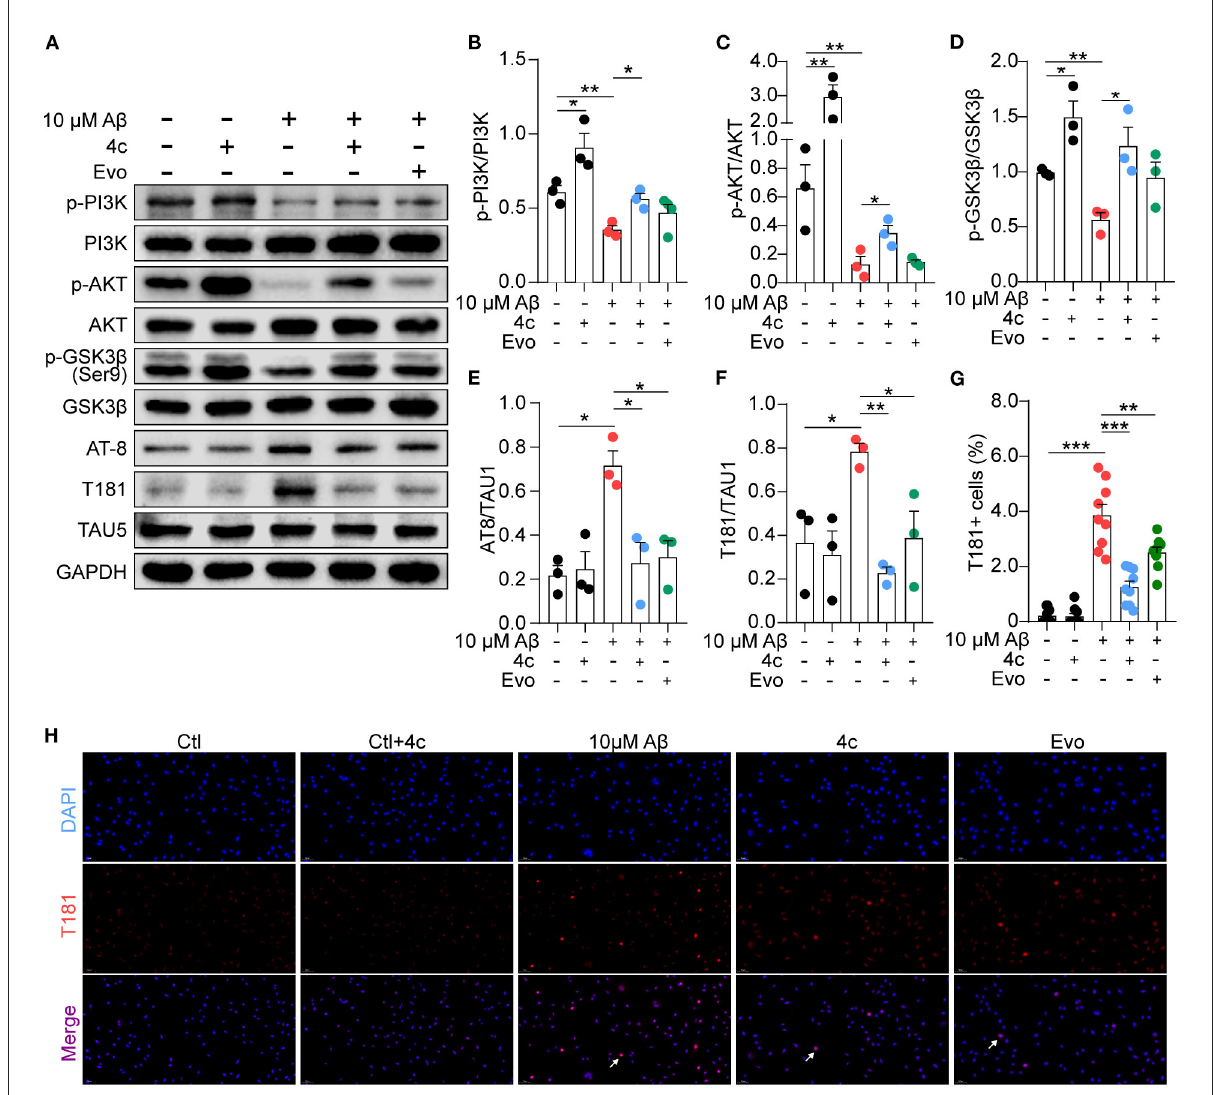
FIGURE9 Determination of PI3K/AKT/GSK3 β and Tau phosphorylation in vitro . A Tau phosphorylation cell model was established by treating SH-SY5Y cells with 10 µ M A β 1-42, and the cells were treated without or with 4c (0.1 µ g/ml) or Evo (0.1 µ g/ml) for 24h. (A) The phosphorylation of p-PI3K, p-AKT, p-GSK-3 β , and Tau in SH-SY5Y cells was detected by western blot using antibodies recognizing AT-8, T181, and Tau5 ( n = 3). (B–F) The phosphorylation ratios compared with total protein were estimated by ImageJ ( n = 3). (G, H) Tau phosphorylation was detected by immunofluorescent staining with anti-T181 antibody ( n = 9 fields). Data are represented as mean ± SEM; * P < 0.05, ** P < 0.01, and *** P <